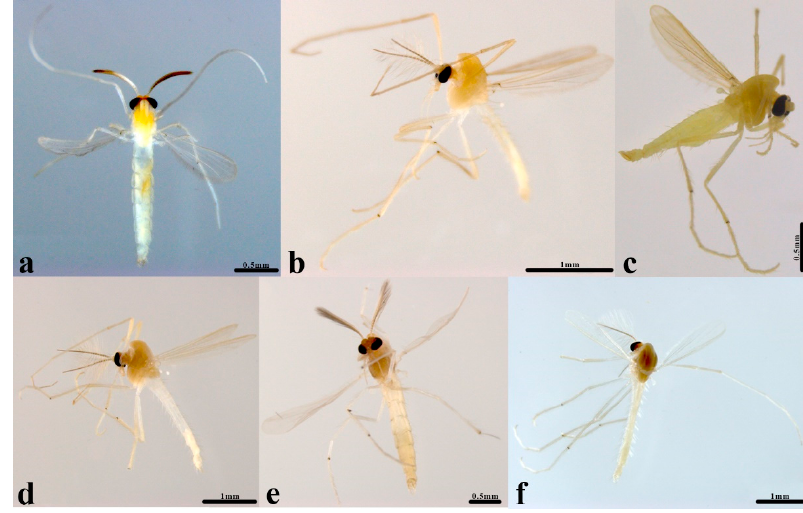
Figure 1. Adult males of Rheotanytarsus muscicola species group. ( a ) Rheotanytarsus falcipedius , dorsal view; ( b ) Rheotanytarsus ferringtoni sp. n. , lateral view; ( c ) Rheotanytarsus fluminis , lateral view; ( d ) Rheotanytarsus illiesi , lateral view; ( e ) Rheotanytarsus muscicola , ventral view; ( f ) Rheotanytarsus photophilus , dorsal view .